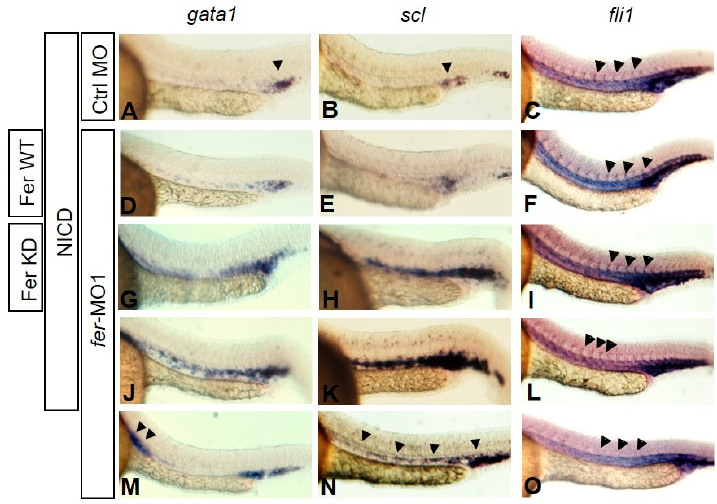
Figure 8. Fer functions independently of Notch for erythrocyte population expansion but not intersomitic vessel formation. Co-injection of the Notch Intracellular Domain (NICD), along with wildtype (WT) or kinase-inactive (KD) Fer, showed that active Notch partially rescues vascular migration in the absence of Fer ( fli1 : ( F )—WT, ( I )—KD), but not excess erythrocyte proliferation ( gata1 : ( D ), WT, ( G ), KD; scl: ( E ), WT, ( H ), KD), when compared to fer-MO1 embryos containing only the NICD ( J , K , L ). Control MO embryos with injected NICD show normal gene expression of gata1 ( A ), scl ( B ) and fli1 ( C ). fer -MO1 alone— gata1 ( M ), scl ( N ) and fli1 ( O ). Embryos examined at 30 somites (~28 hpf).